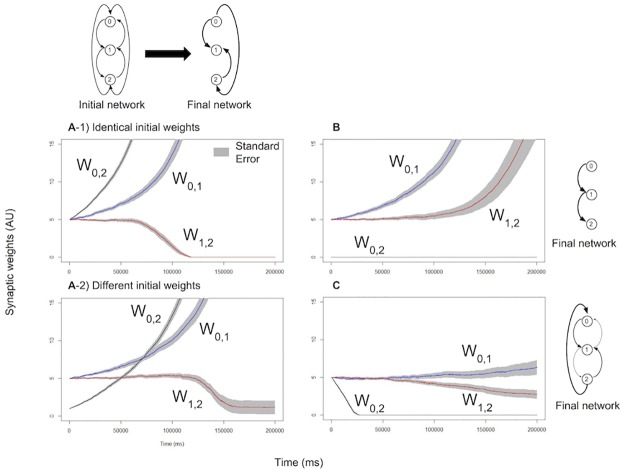
Dynamics of weight changes induced by LSA in small networks of 3 neurons.A) Reinforcement: spiking of neuron 2 stops the stimulation in neuron 0. The direct weight w0,2 grows faster than other weights, even when starting at a lower value. B) Artificially fixing the direct weight w0,2 to 0, a longer pathway of 2 connections 0 → 1 → 2 is established. C) Pruning: spiking of neuron 2 starts external stimulation to neuron 0. As a result, w0,2 is pruned.